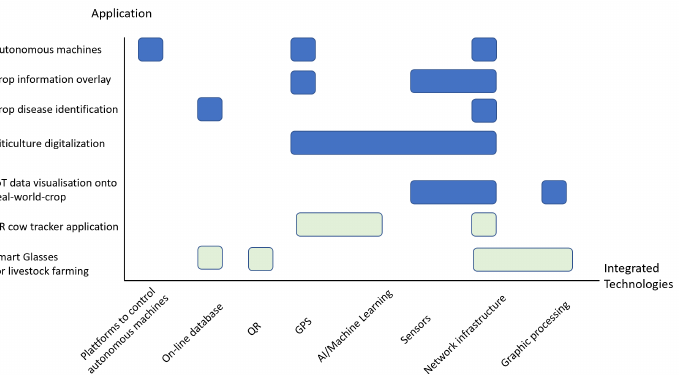
Figure 6. Analysis of technologies coupled with AR in Farming. Dark blue refers to crop-bases articles, whereas light green is for livestock, adapted. For details, please refer to the original paper by Hurst et al. (2021)